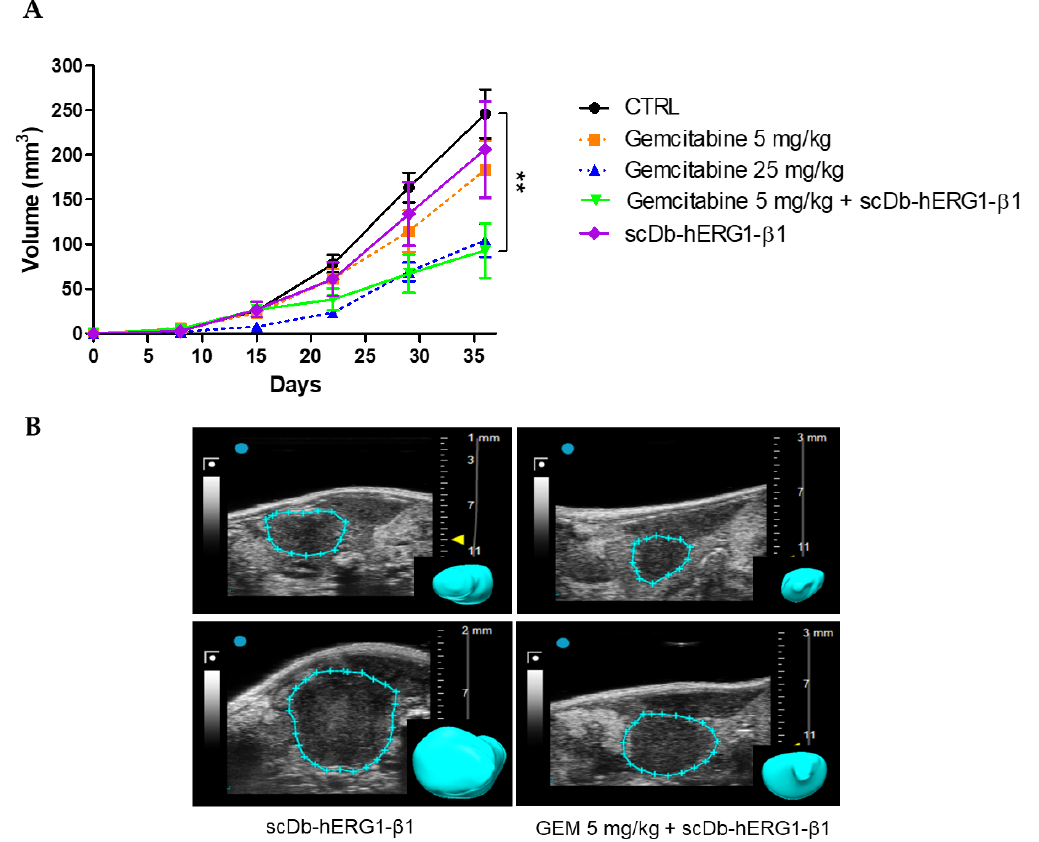
Figure 7. Effects of Gemcitabine in combination with the scDb-hERG1- β 1 in the orthotopic xenograft PDAC mouse model. ( A ) Time course of PDAC tumour growth in mice treated with saline (CTRL), scDb-hERG1- β 1 (16 mg/kg) and the combination Gemcitabine (5 mg/kg) and scDb-hERG1- β 1 (16 mg/kg). The Gemcitabine 25 mg/kg and Gemcitabine 5 mg/kg groups are reported as dashed lines. Control ( n = 15) vs. Gemcitabine 5 mg/kg scDb-hERG1- β 1+ ( n = 5) p = 0.003; control vs. ScDb-hERG1- β 1 p = 0.5 ( n = 9), Student’s t test. ( B ) Representative US images of tumour masses at the beginning of the treatment (upper panels) and at the end point (lower panels). The rendered 3D of the tumour masses are shown in the insets. Data are presented as mean values ± s.e.m. ** p <